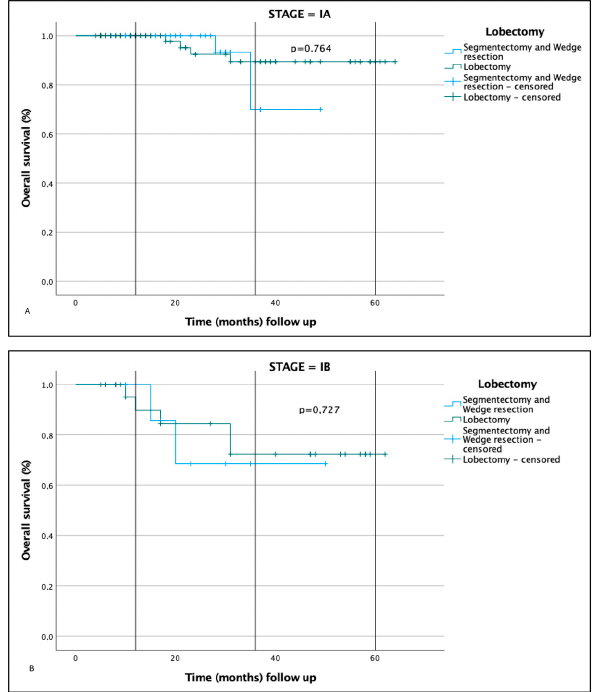
Figure 1. Overall survival (OS) (%) of all the enrolled patients. OS comparison between lobectomy and segmentectomy (typical and atypical) for disease stages IA ( A ) and IB ( B ), respectively.